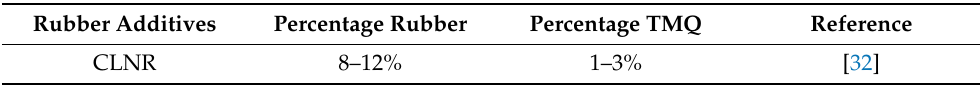
Table 12. Application of TMQ in rubber